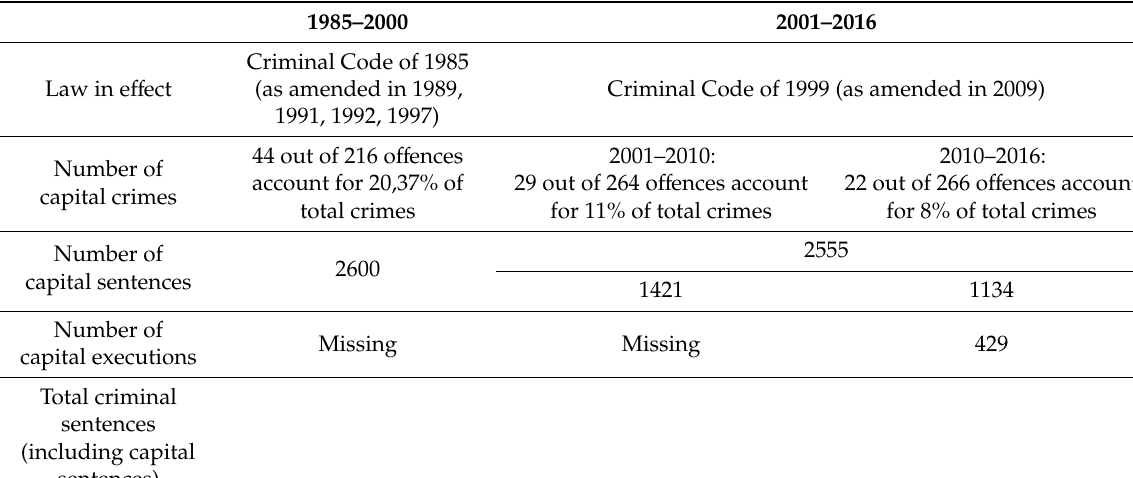
Table 4. Combined number of death sentence between 1985 and 2016